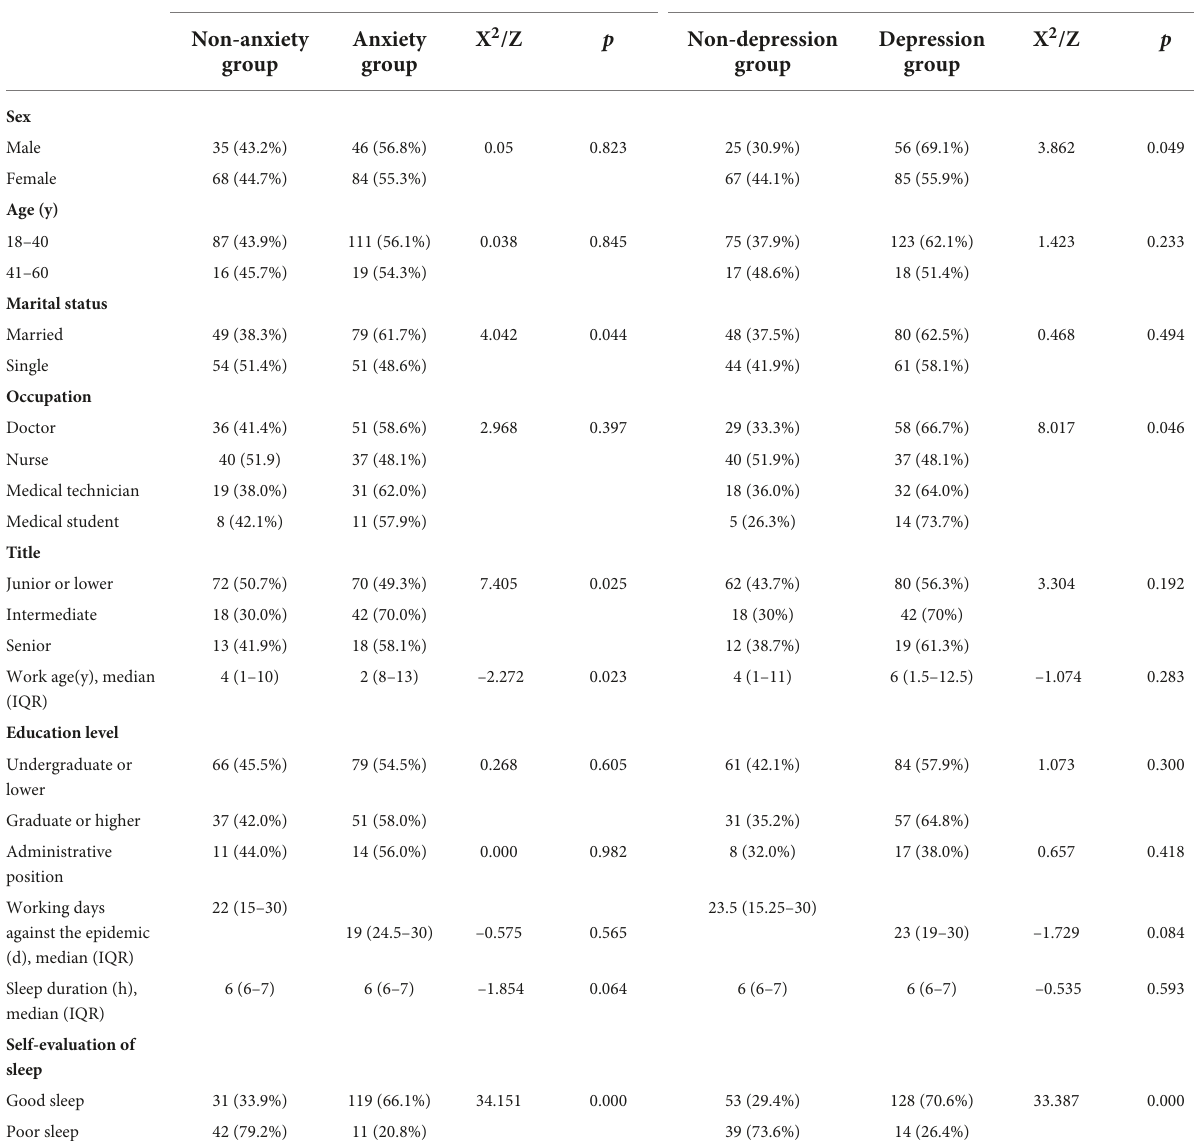
TABLE 1 Univariate analysis of anxiety and depression among medical